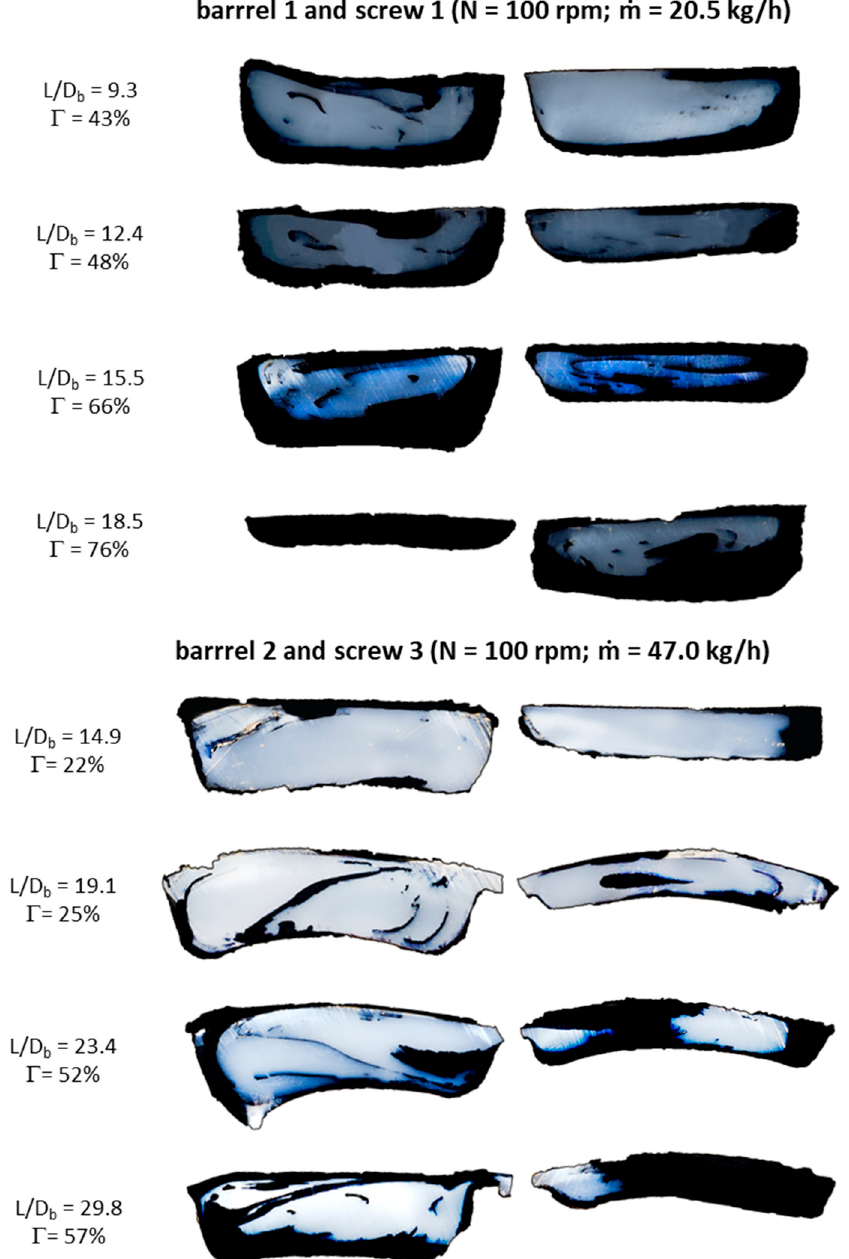
Figure A1. Cross sections along the wave zone obtained from the solidification experiments for two screw-barrel configurations: barrel 1 and screw 1, and barrel 2 and screw 3. Both tests were carried out at a screw speed of 𝐍 = 𝟏𝟎𝟎 rpm, which resulted in a throughput of 𝐦(cid:4662) = 𝟐𝟎.𝟓 kg/h and 𝐦(cid:4662) = 𝟒𝟕.𝟎 kg/h for the first and the second screw-barrel configuration, respectively. Table A1. Operating points. Mean values of process parameters measured in the experimental part.